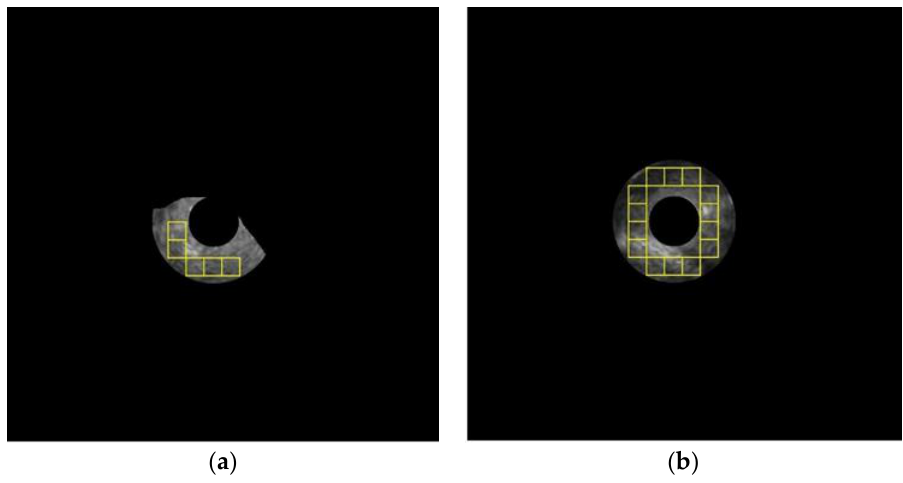
Figure 16. Misclassification of the multi-patch-based model: ( a ) malignant lesion was misclassified as benign; ( b ) benign lesion was misclassified as malignant.